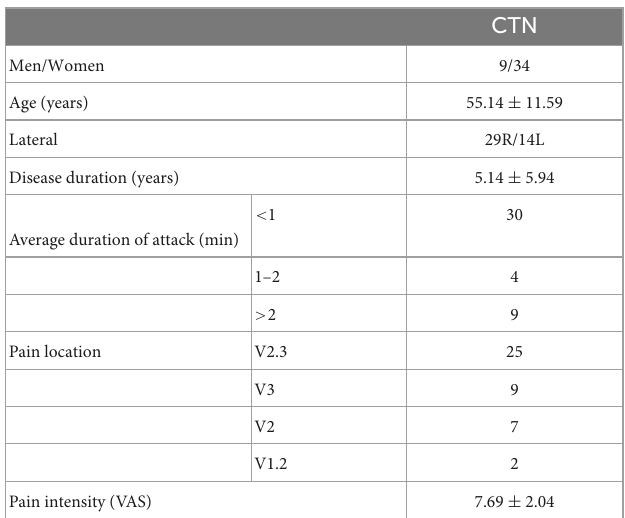
TABLE 1 Demographics and behavioral results of